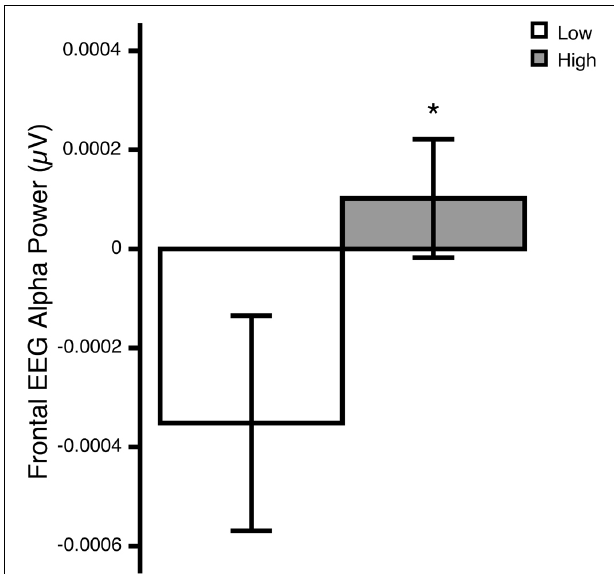
FIGURE 1 | Overall frontal EEG alpha (8–13 Hz) power at rest in young adults self-reporting low (white bars) and high (gray bars) OCD-related behaviors. * p < 0.05. Means (cid:6) 1 SE. Note: because alpha power is inversely related to activity, higher power reflects lower